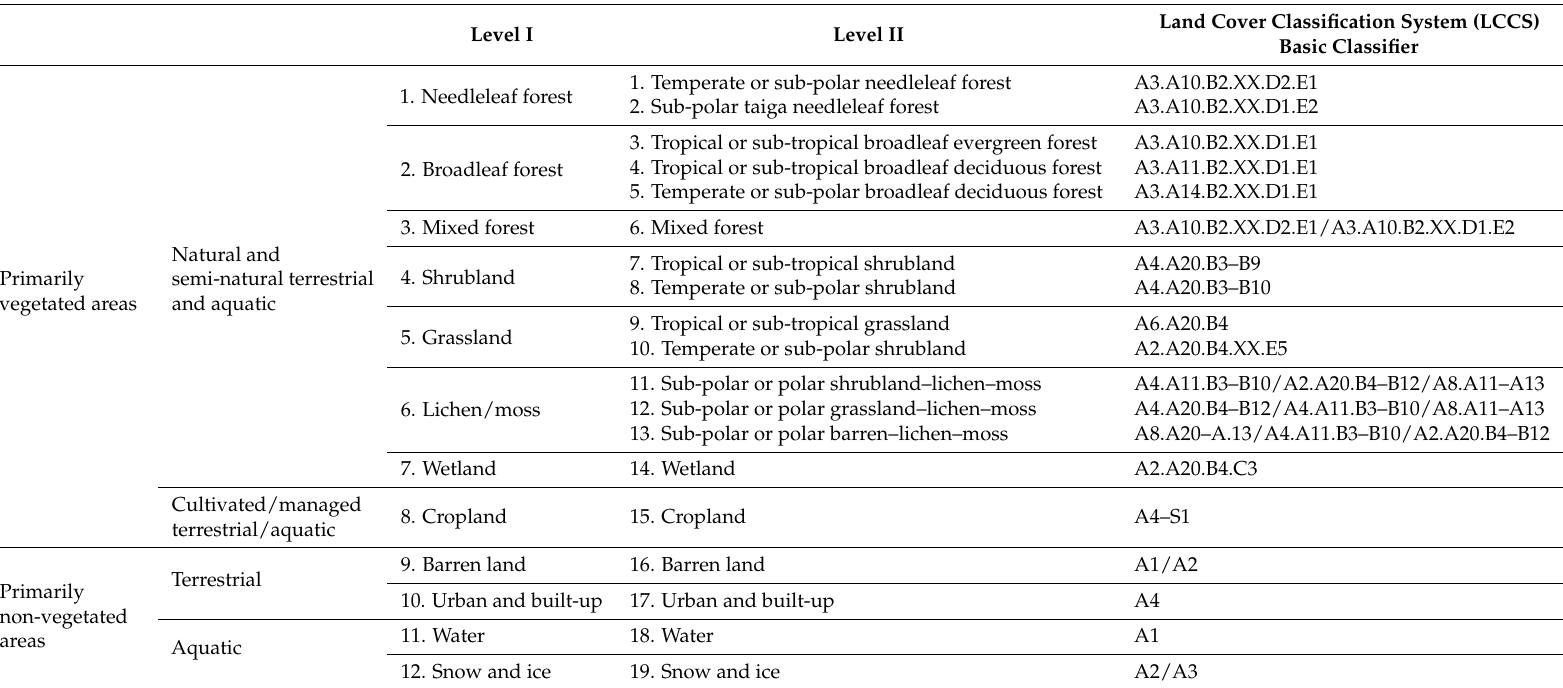
Table 3. North American Land Change Monitoring System (NALCMS) land cover classification legend level I and